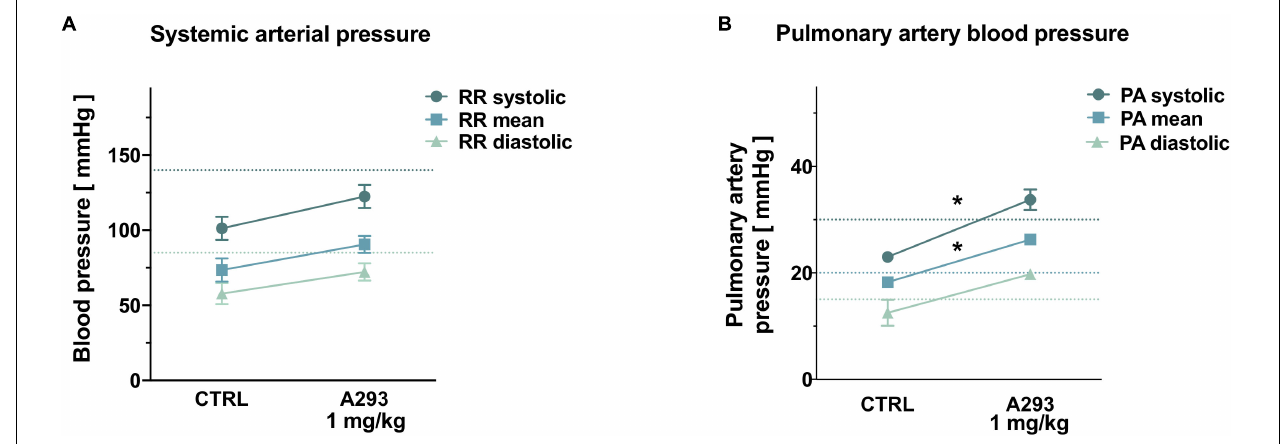
FIGURE 5 | Effects of TASK-1 inhibition on pulmonary artery pressure. (A,B) Systemic arterial (A) and pulmonary artery (B) blood pressure levels of n = 4 anesthetized pigs under control conditions (CTRL) and after intravenous application of A293 (1 mg/kg body weight). Means of n = 4 animals; error bars, SEM; * P < 0.05 from Student’s t -tests; dotted lines mark the normal range in humans.